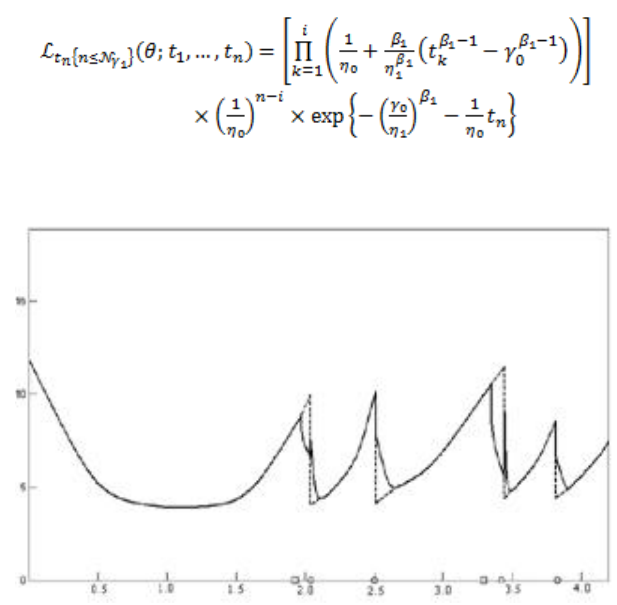
Figure 4. Reformulation in the bath-tub form of the self-excited and relative intensities of the BP